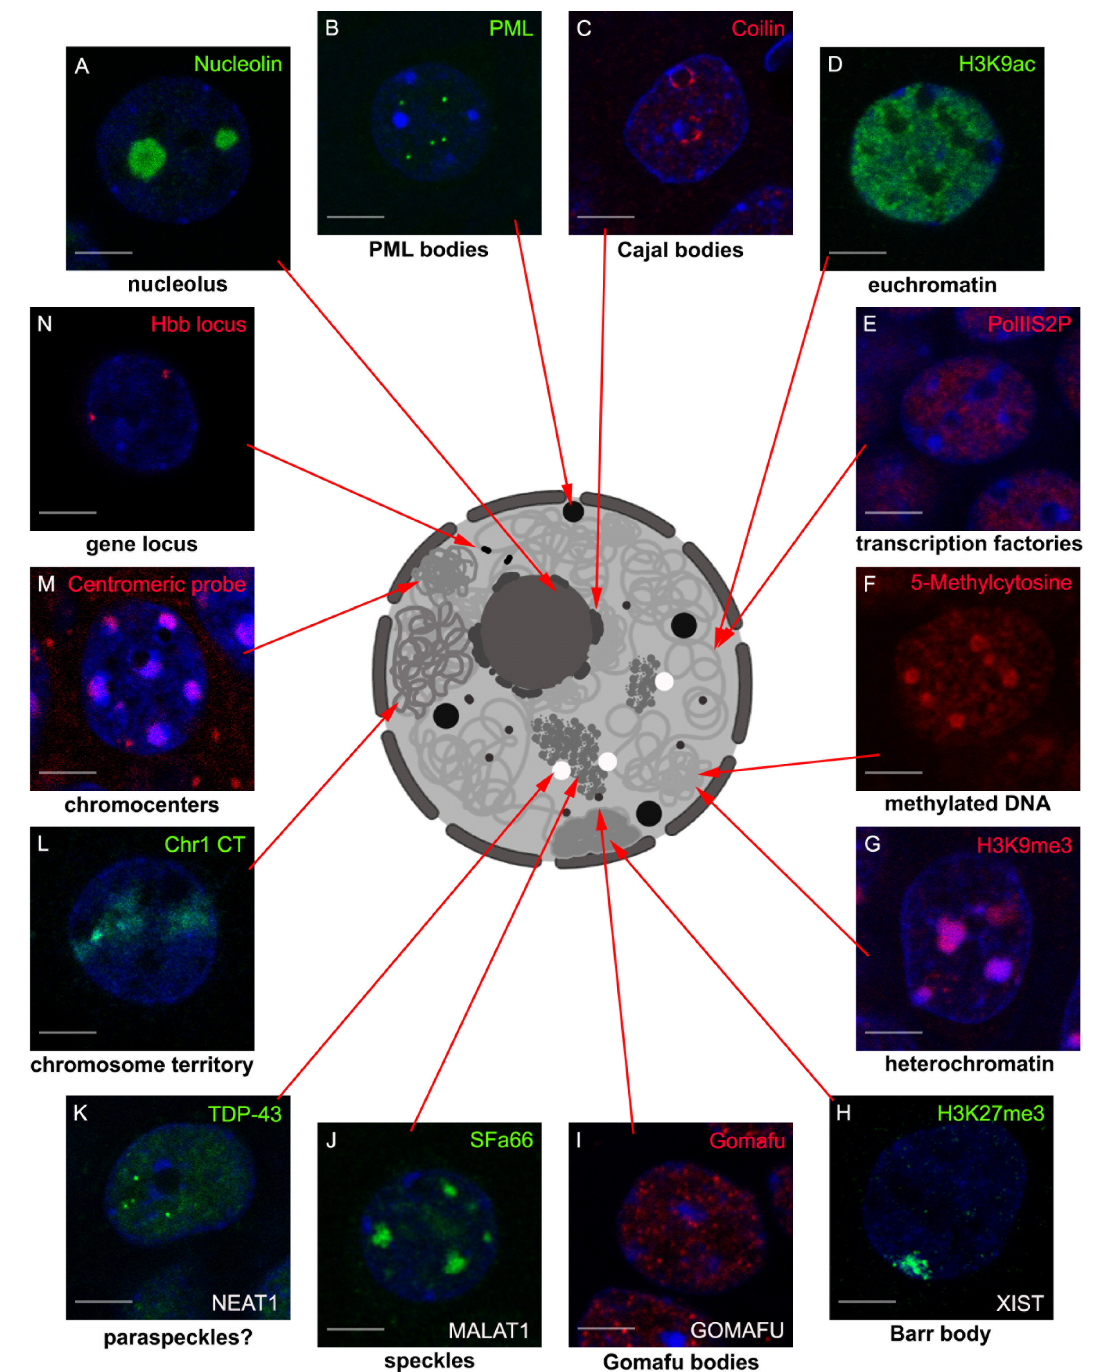
Figure 1. Functional and structural domains of the neuronal cell nucleus. To emphasize the complexity of the neuronal nucleus, different functional and structural assemblies were stained in rodent hippocampal neurons using either antibody recognizing marker proteins or FISH probes complementary to specific sequences. The intricate architecture of the neuronal nucleus consists of nuclear bodies like the nucleolus ( A , [30]), and PML ( B , [16]) and Cajal bodies ( C , [17]); regions of actively transcribed genes marked by the acetylated histones ( D ) and activated RNA polymerase II ( E ); and regions of silenced chromatin characterized by methylated DNA ( F ) and methylated histone H3 ( G ). It contains also nuclear domains like Barr bodies ( H ), Gomafu bodies ( I ), speckles ( J ), and paraspeckles ( K ), the assembly and function of which fully rely on lncRNAs (highlighted in white). The genome components like gene loci ( L ), chromosome territories ( M ), and repetitive sequences in chromocenters ( N ) are also shown. Scale bar is 5 µ